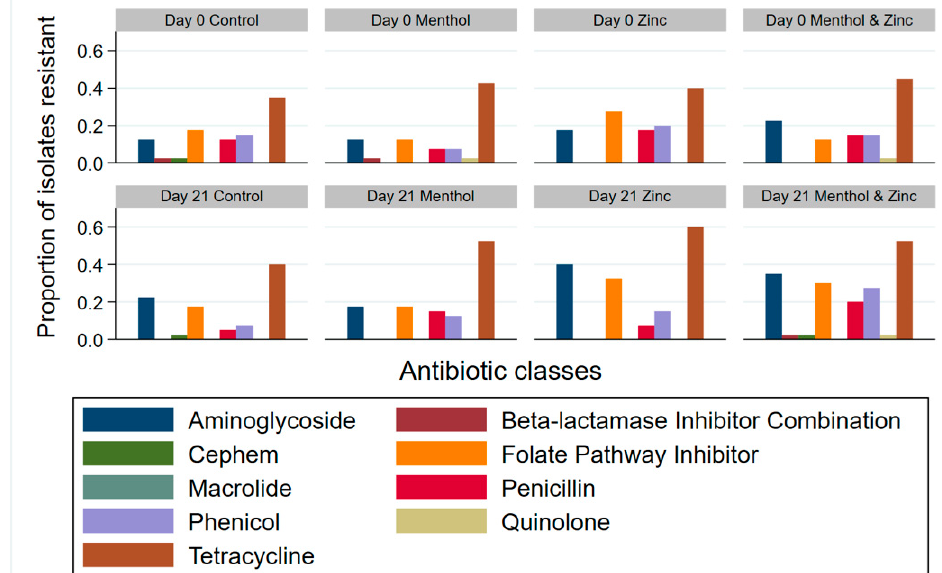
Figure 3. Resistance (proportion) of Escherichia coli isolates to each antibiotic class by sample day and treatment.